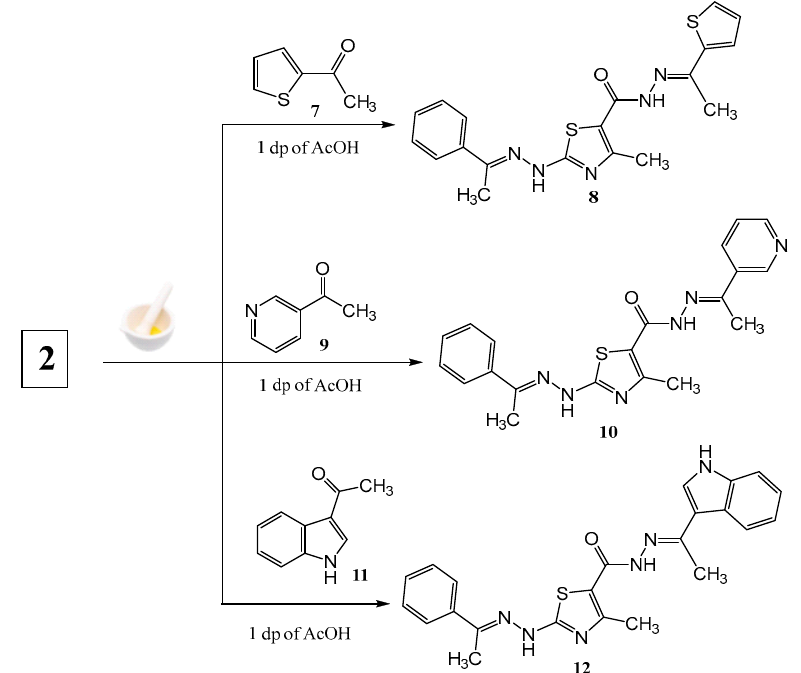
Scheme 3. Synthesis of pyrazole derivatives 14a , b and 16